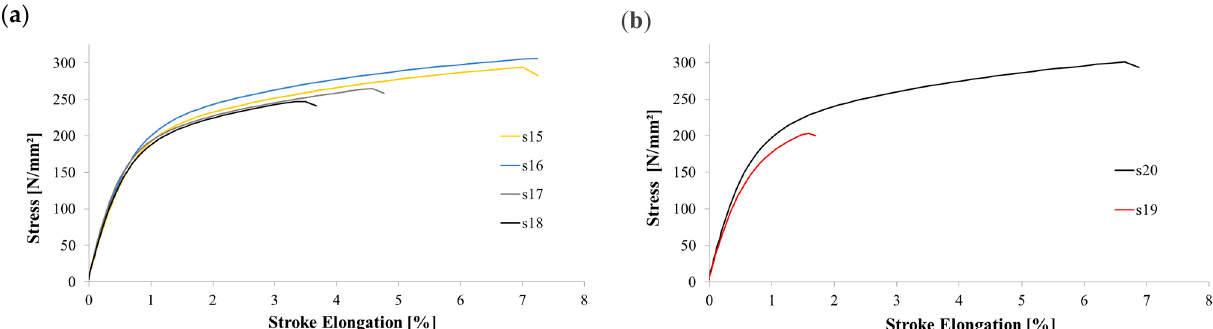
Figure 8. Tensile Test Results in 1 mm-min stroke speed of AlMgCu Alloyed ( a ) A1 alloy Set (Nb)